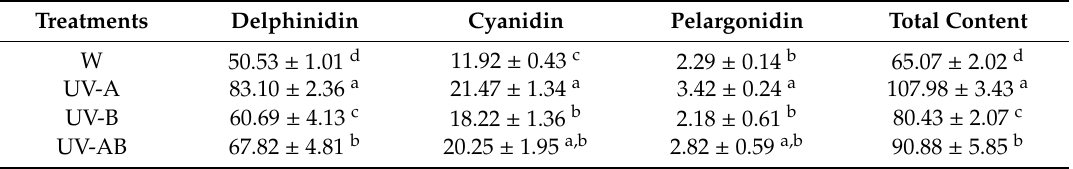
Table 2. Anthocyanidin contents in different treatments detected by HPLC method (mg/100 g, Means ± SD).